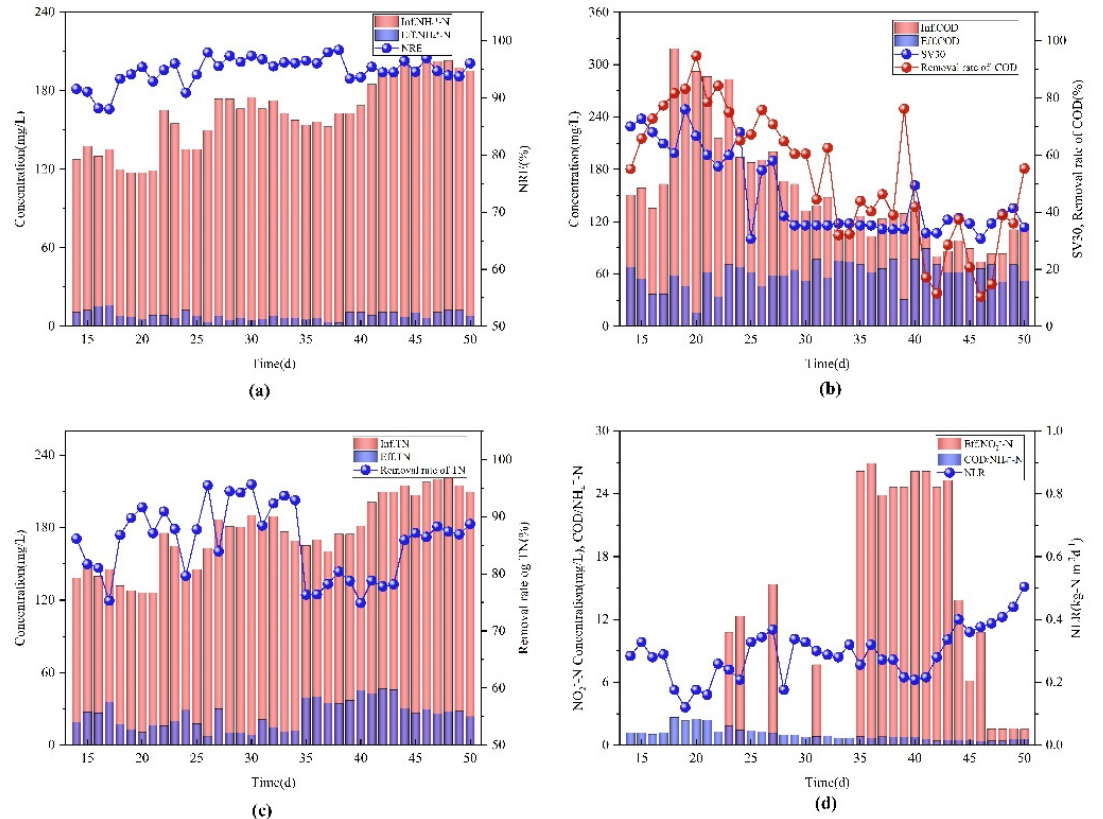
Figure 4. Changes in indexes during NLR domestication stage; ( a ) NH 4+ -N concentration and NRE in inlet and outlet water; ( b ) COD concentration in inlet and outlet water, COD removal rate and changes in SV30; ( c ) TN concentration and TN removal rate in inlet and outlet water; ( d ) effluent NO 2 − -N, NLR, and